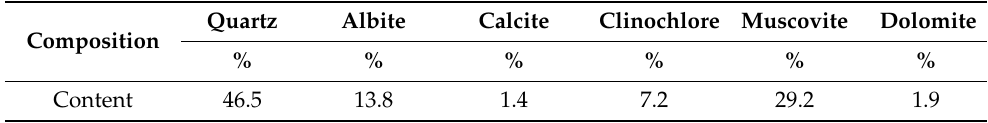
Table 2. The semi-quantitative analysis results based on